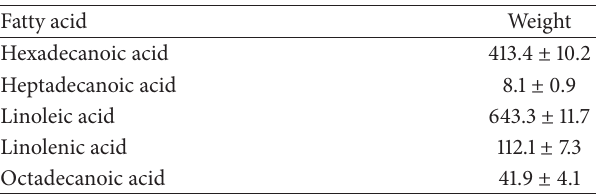
Table 4: Fatty acid composition of O. japonicus tubers (mg/100g